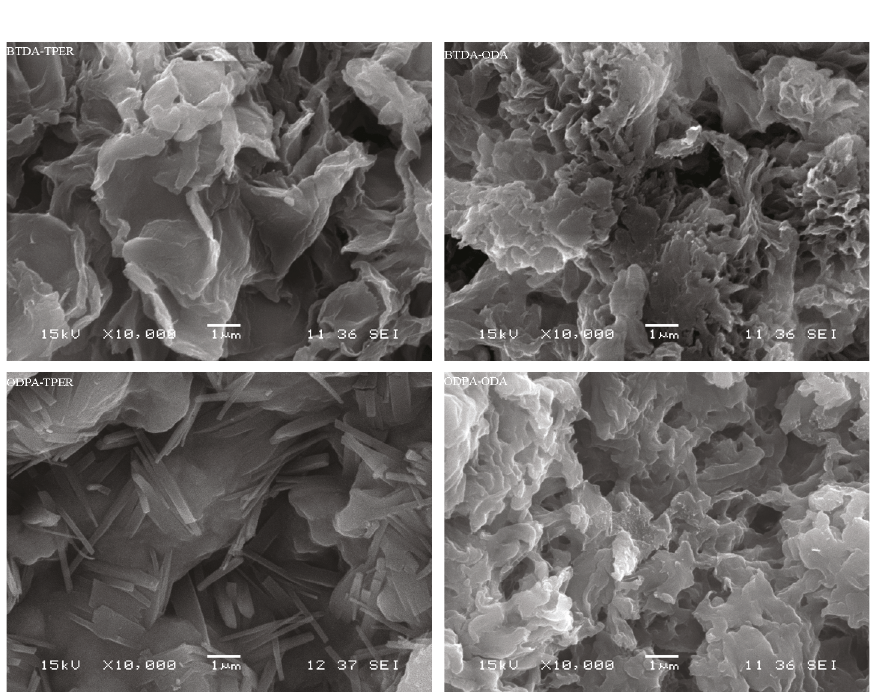
Figure 5: SEM images of